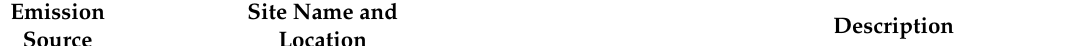
Table 1. Location and economic activity description of selected